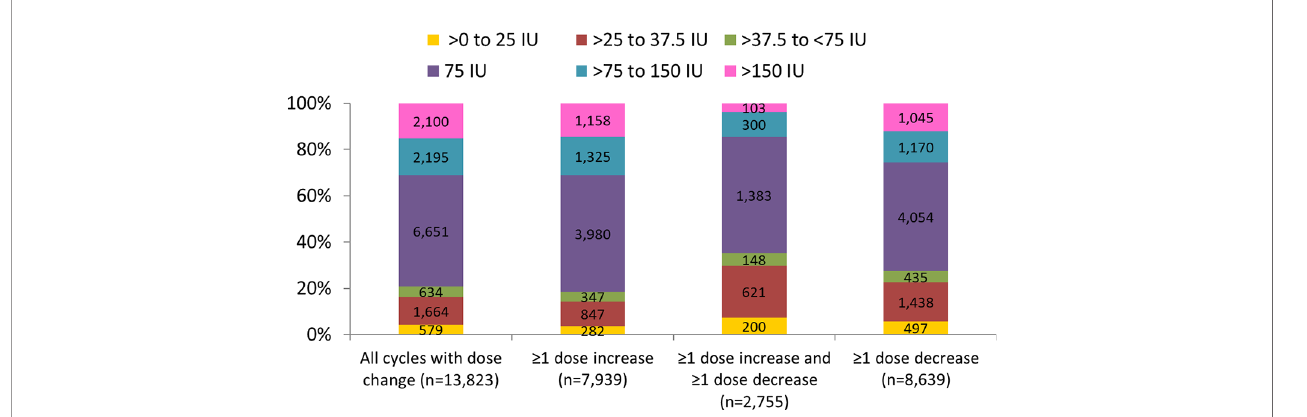
FIGURE 3 | Minimum dose adjustment per cycle. Data are presented as number and proportion in each dosing category. ≥ 1 dose increase includes all cycles with at least one dose increase (regardless of any decrease). ≥ 1 dose decrease includes all cycles with at least one dose decrease (regardless of any